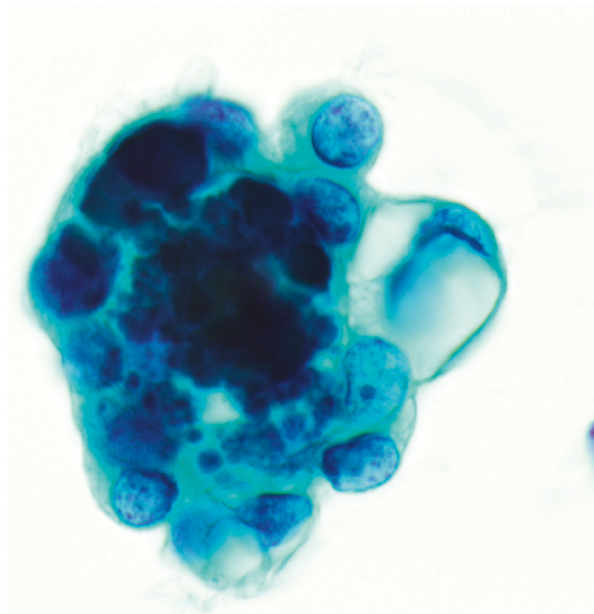
Figure 1: Ascites cytology after RRSO. An atypical cell cluster is seen. Atypical cells show unevenly distributed nuclei, overlapping nuclei, anisonucleosis, and prominent nucleoli. RRSO: risk-re- ducing